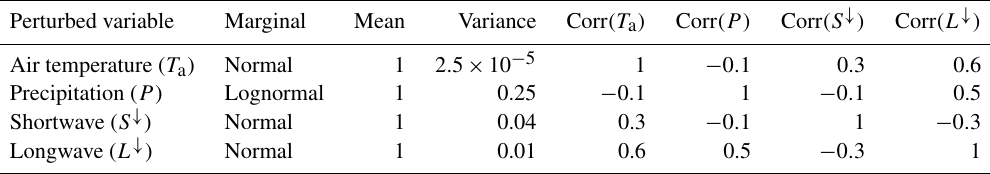
Table 1. Hyper-parameters (means, variances and correlations) defining the joint probability distribution from which the ensemble of mul- tiplicative perturbation parameters are drawn (unitless). These parameters were obtained from De Lannoy et al. (2012) which, in turn, were based on the approach of Reichle et al.